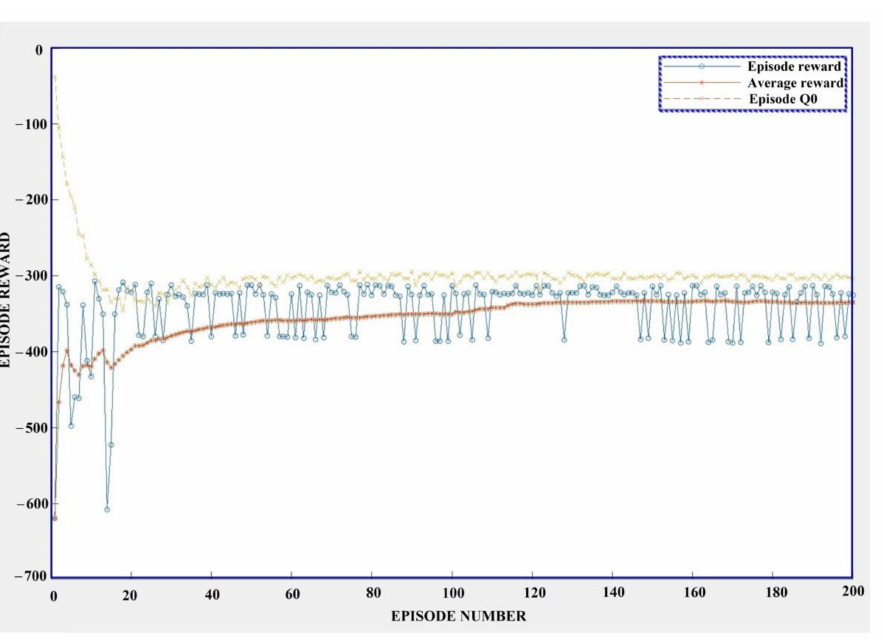
Figure 10. Training stage of the RL-TD3 agent for the correction of u dref and u qref